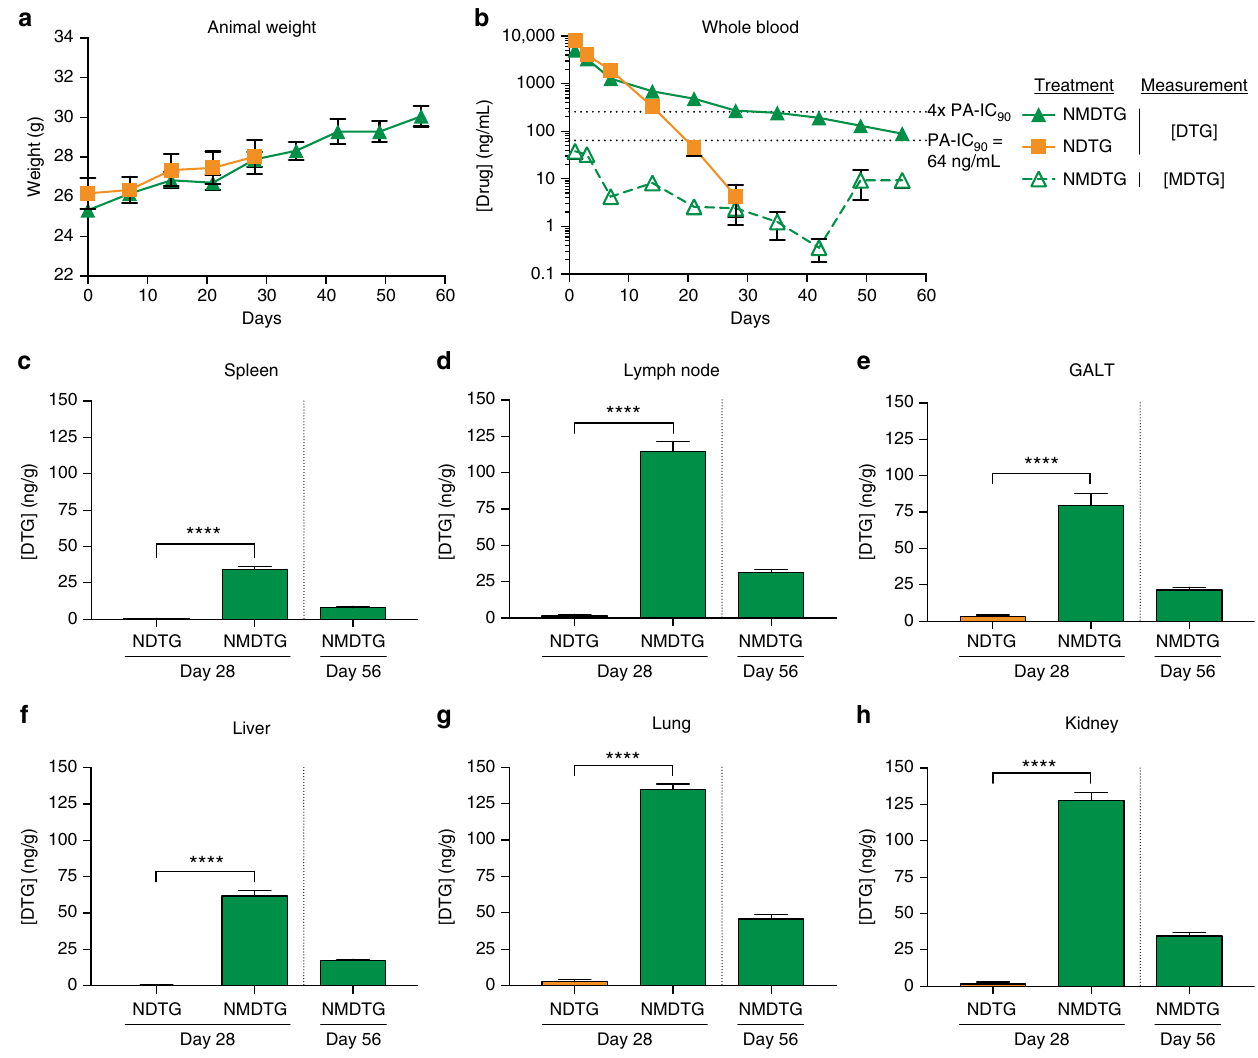
Fig. 5 Pharmacokinetics. Balb/cJ mice were administered a single IM dose of NDTG or NMDTG (45 mg/kg DTG-eq.) to determine pharmacokinetic (PK) pro fi les. a Animal weights were monitored for the length of the study to assess animal health. b Blood DTG and MDTG concentrations were analyzed by UPLC-MS/MS. Solid lines indicate [DTG], while the dashed line indicates [MDTG] from NMDTG treatment. Dotted lines indicate the PA-IC 90 (64 ng/mL) and four-times the PA-IC 90 (256 ng/mL). c – h Tissue DTG concentrations were analyzed by UPLC-MS/MS. ( c ) Spleen, ( d ) lymph node, ( e ) GALT, ( f ) liver, ( g ) lung, and ( h ) kidney DTG levels are shown at days 28 and 56. **** P < 0.0001. Results are shown as the mean ± SEM of at least six biological replicates. Results from c – h were analyzed by two-tailed Student ’ s t test (for all, n = 6 NDTG, 6 NMDTG, degrees of freedom = 10; c t = 14.4; d t = 16.4; e t = 9.3; f t = 17.3; g t = 30.1; h t =